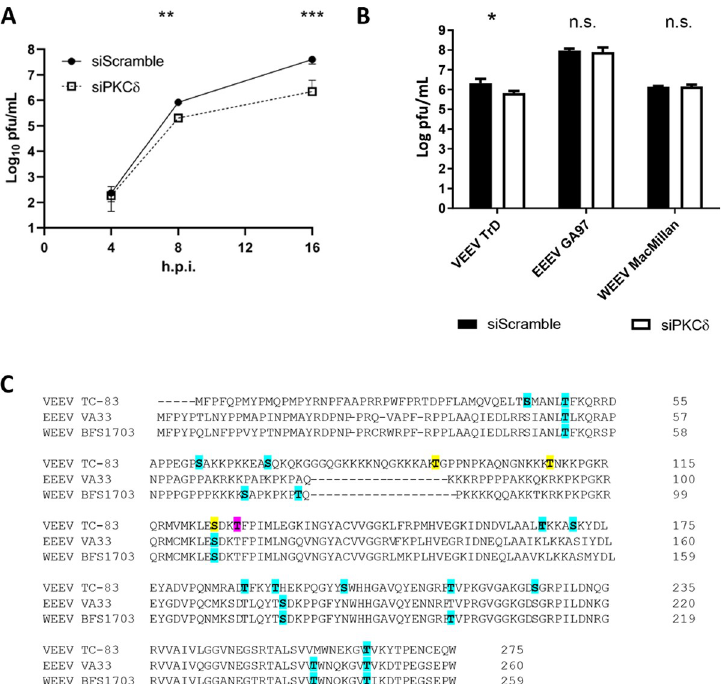
Fig 4. Inhibition of PKC δ causes a decrease in viral replication. U87MG cells were transfected with 50 nM scramble control or PKC δ siRNAs. Seventy-two hours post-transfection, cells were infected with A) VEEV TC-83 (MOI 0.1) or B) VEEV TrD, EEEV GA97, or WEEV 1930 California (MOI 0.1) and viral supernatants collected at 4, 8, and 16 hpi (panel A) or 16 hpi (panel B) for viral titer determination via plaque assay. C) An alignment of the primary amino acid sequence of VEEV, EEEV, and WEEV is displayed. All residues predicted (but not experimentally verified) are bolded and highlighted in cyan. Residues that were predicted and experimentally verified to be phosphorylated are bolded and highlighted in yellow. Thr 127 which was experimentally shown, but not predicted, is bolded and highlighted in pink. Data is the average of 3 biological replicates ± standard deviation � = p < 0.05, �� = p < 0.005, ��� = p < 0.0005.